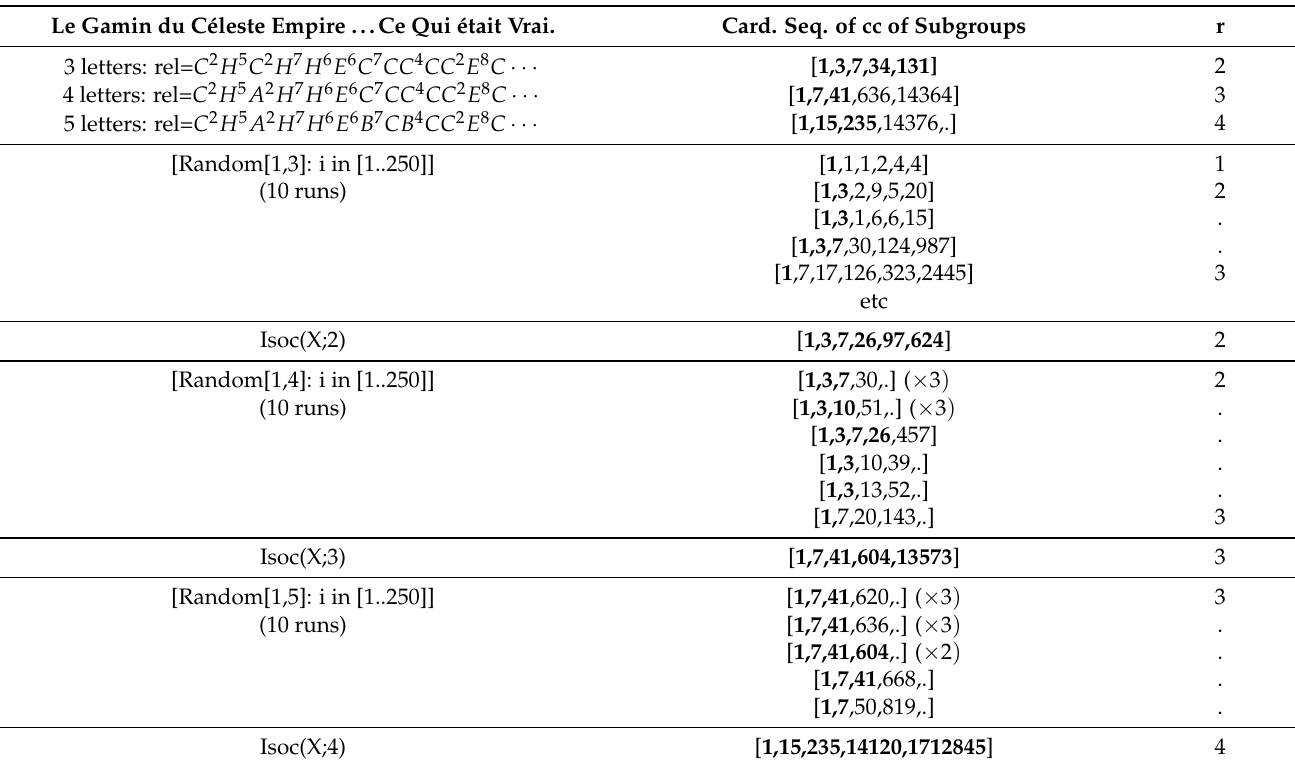
Table 5. Group analysis of an excerpt of a small poem in prose Le vieux saltimbanque by Charles Baudelaire. The text is split into segments encoded by the symbol H (for names and adjectives), E (for verbs), A for prepositions, B for adverbs, or C (for the other types: conjunctions, punctuation marks and so on). The cardinality structure of the cc of subgroups of a small index is compared to the one obtained with 10 runs of a sequence of words of a similar length (i.e., the length 250) with the corresponding number of letters. Le Gamin du Céleste Empire ...Ce Qui était Vrai. Card. Seq. of cc of Subgroups